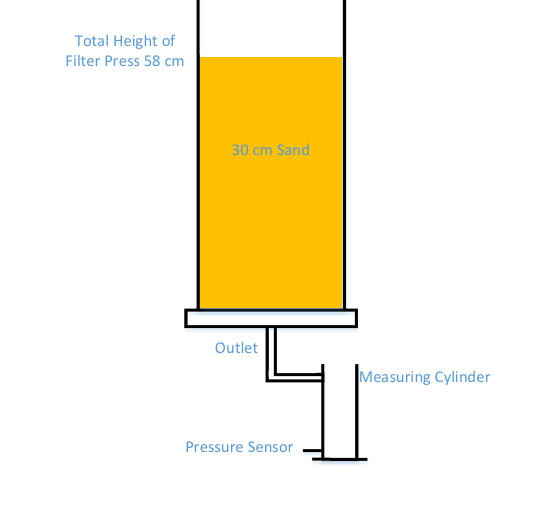
Fig. 2 Modified filter press